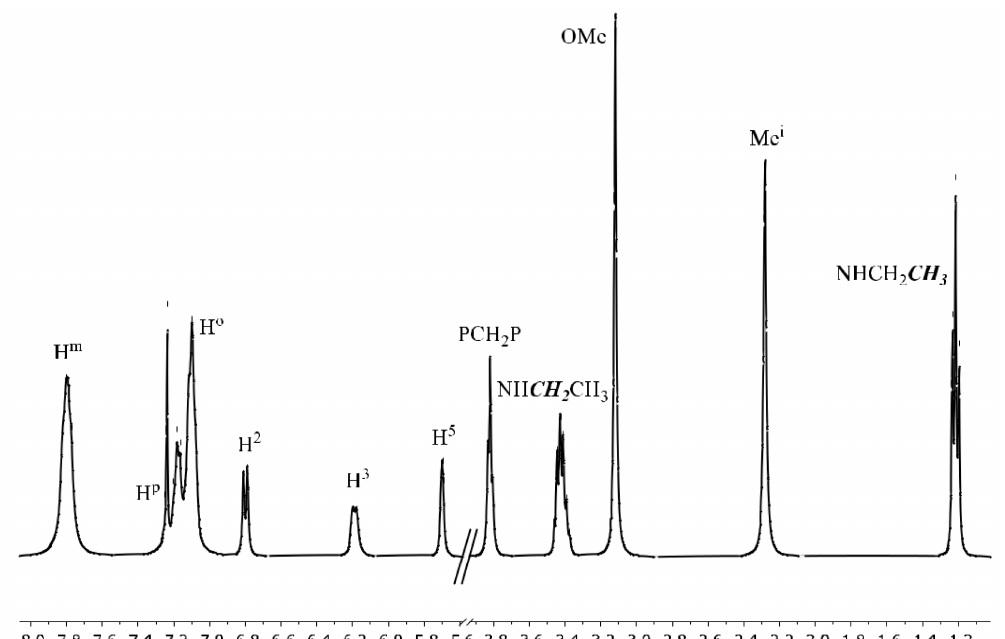
Figure 2. 1 H NMR spectrum of compound 3c in CDCl 3